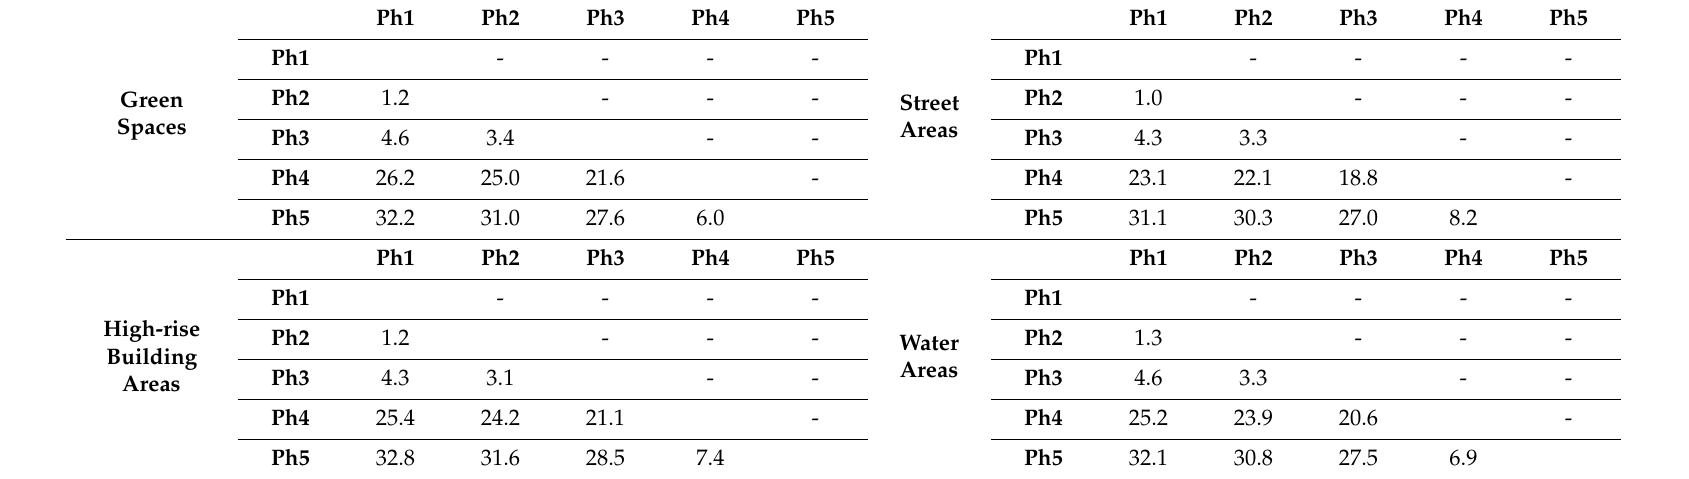
Table 7. Duration of vegetative phases (Ph1–Ph5) depending on the form of land cover (in weeks).